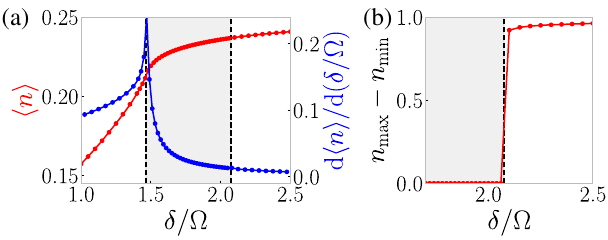
FIG. 3. Detecting phase transitions via filling fraction. These data are obtained for an infinitely long cylinder with XC-8 geometry. (a) The filling fraction has a singular behavior upon transitioning from the trivial phase into the spin liquid, after which the system enters a regime where h n i ≈ 0 . 25 , consistent with it being an approximate dimer state. (b) The spin liquid and VBS phase are separated by a first-order transition.